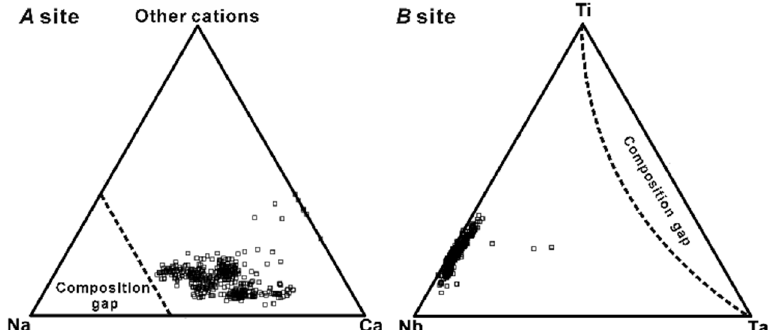
Figure 11. Triangular diagrams of the A -site and B -site compositions of the pyrochlore group min-